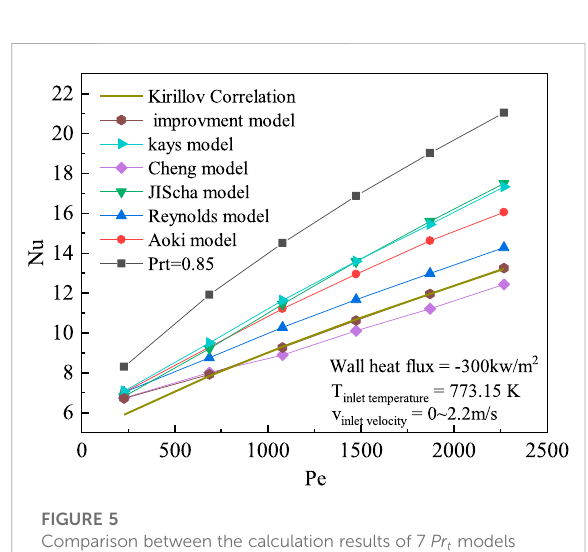
FIGURE 5 Comparison between the calculation results of 7 Pr t models and Kirillov ’ s